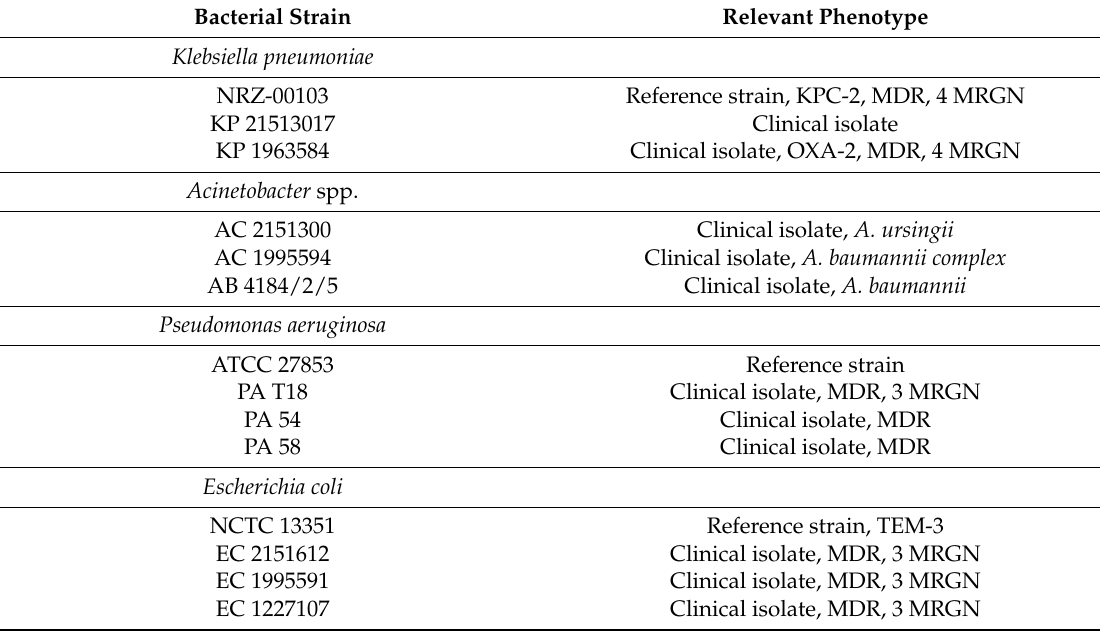
Table 2. Characteristics of the ESKAPE Gram-negative strains used in this